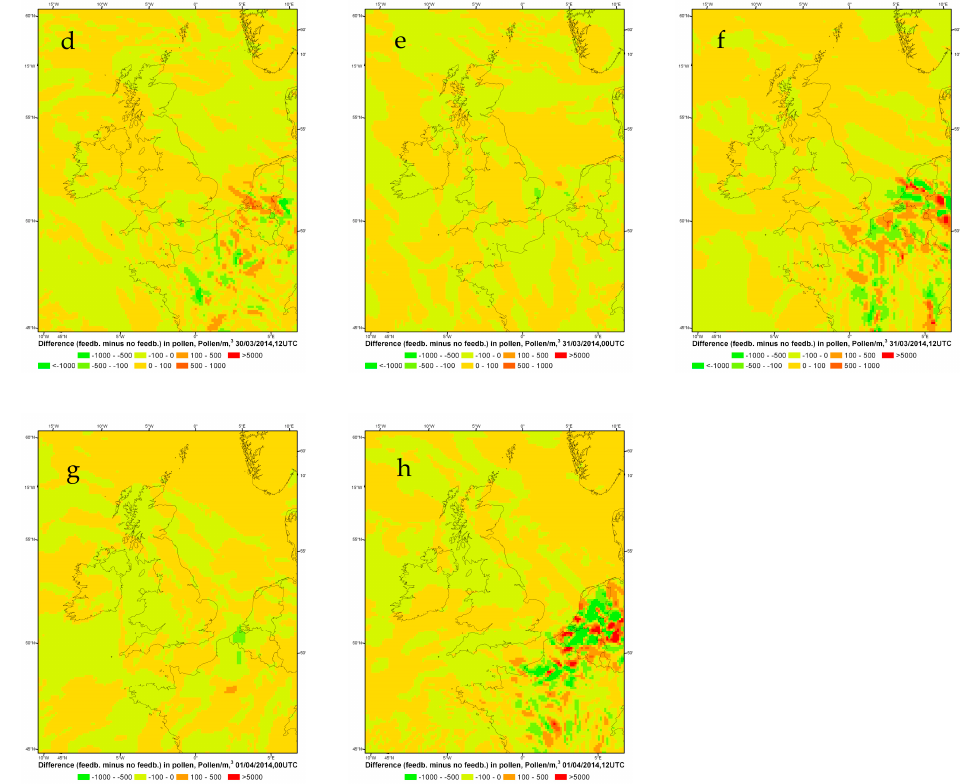
Figure 5. Calculated difference in birch pollen concentration (pollen/m 3 ) between the two options with radiation feedback and without radiation feedback during four days ( a – h ) 29 March–1 April 2014 with a 12 ‐ h interval going from the top left to lower right. The results are based on the WRF ‐ Chem calculations using the emission scenario without UK emissions.